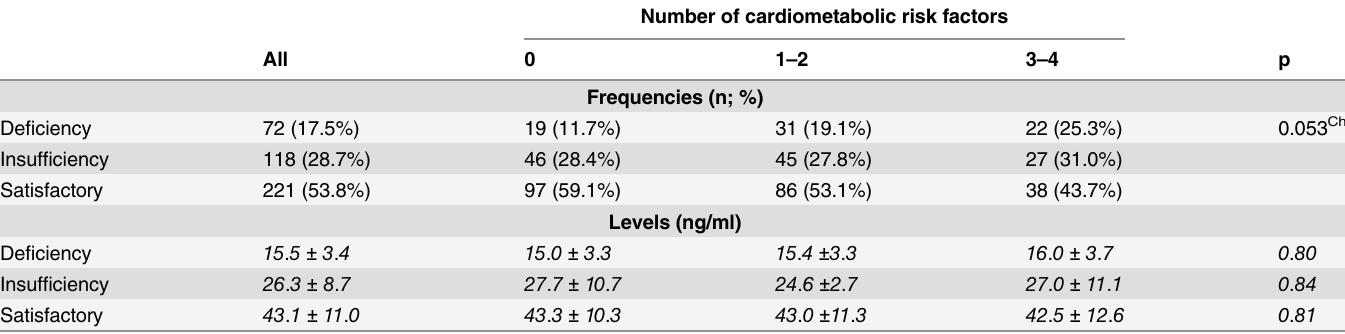
Table 3. 25(OH)D 3 status and plasma levels according to presence of cardiometabolic risk factors.